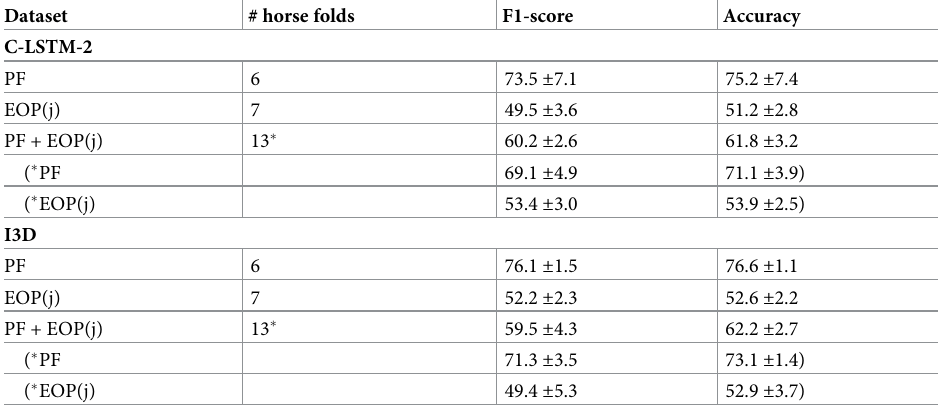
Table 4. Results (% F1-score) for intra-domain cross-validation for the respective datasets and models. The results are averages of five repetitions of a full cross-validation and the average of the per-subject-across-runs standard deviations.